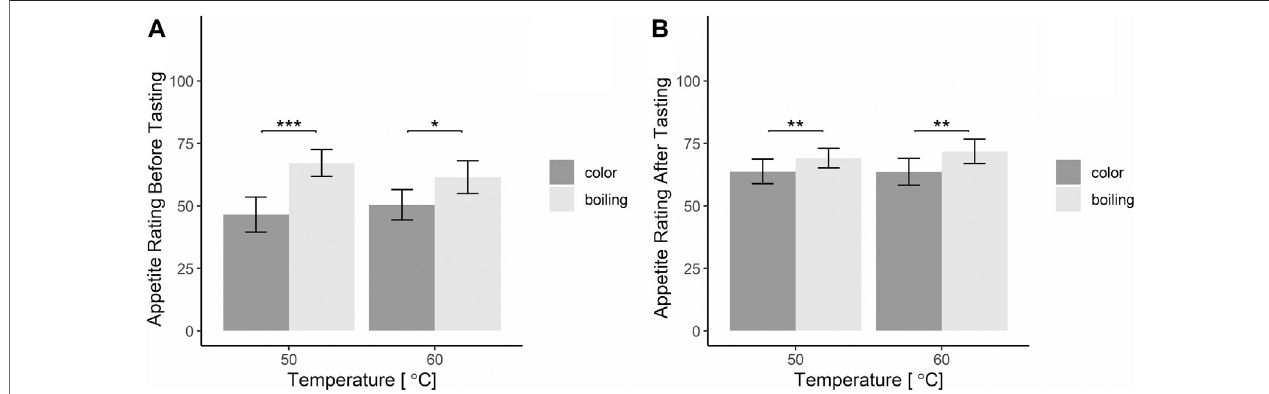
FIGURE 9 | (A) Appetite ratings before tasting and (B) after